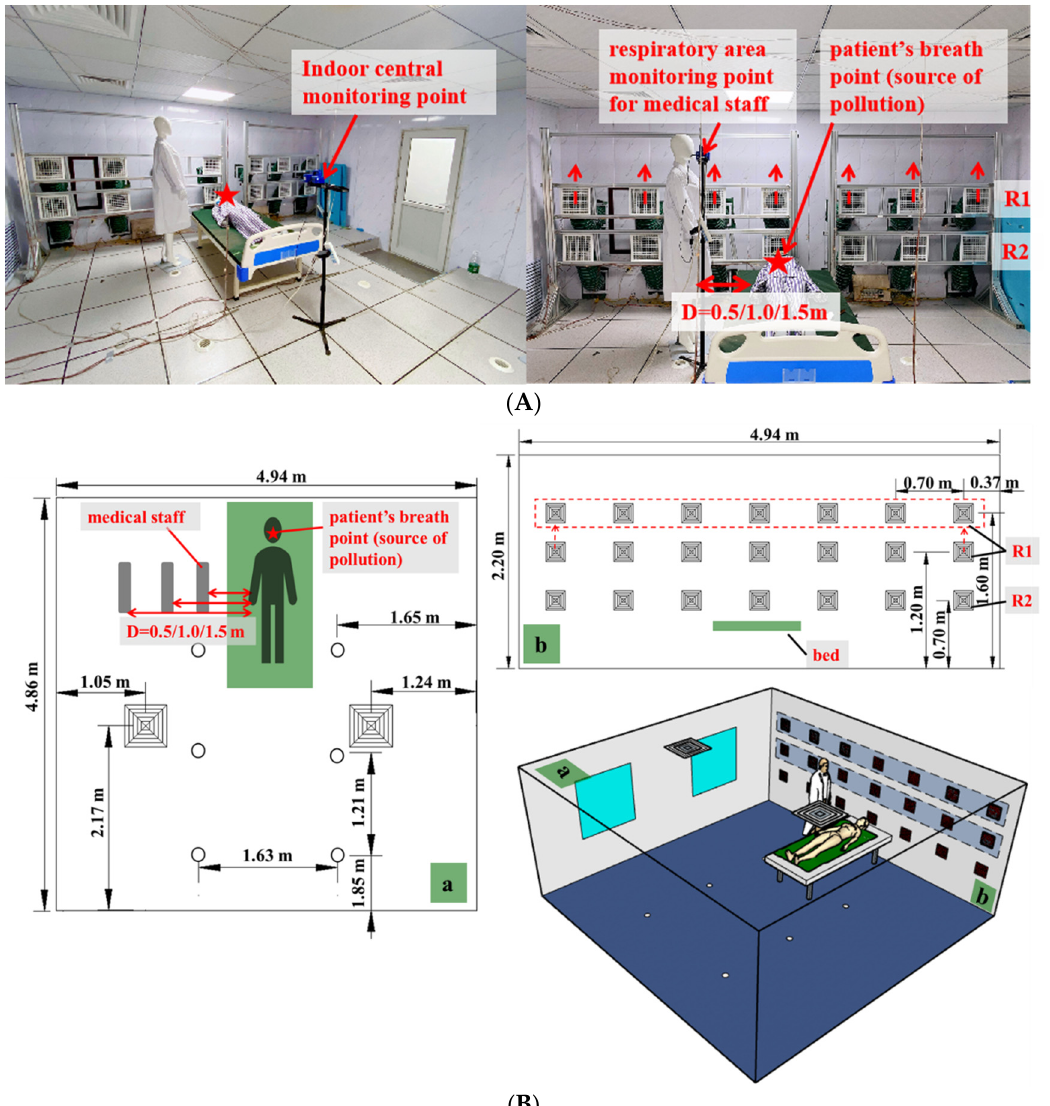
Figure 1. Schematic diagram of experimental chamber. ( A ) The layout of the central measurement point, medical staff measurement point, pollution source release point and return air inlets in the laboratory; ( B ) Dimensions of the experimental chamber.